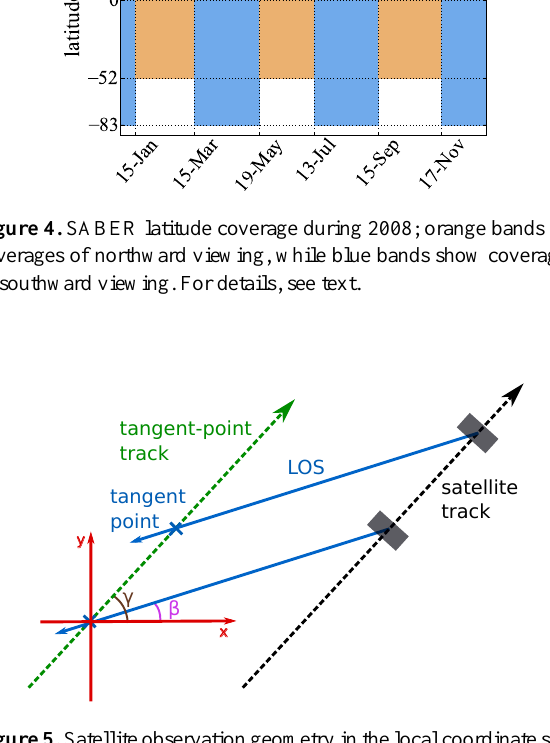
Figure 5. Satellite observation geometry in the local coordinate sys- tem in the two-dimensional horizontal plane. The black dashed line indicates the satellite track, while the green dashed line shows the tangent-point track. Blue lines are LOS. Red axes represent the lo- cal coordinate system. For details, see